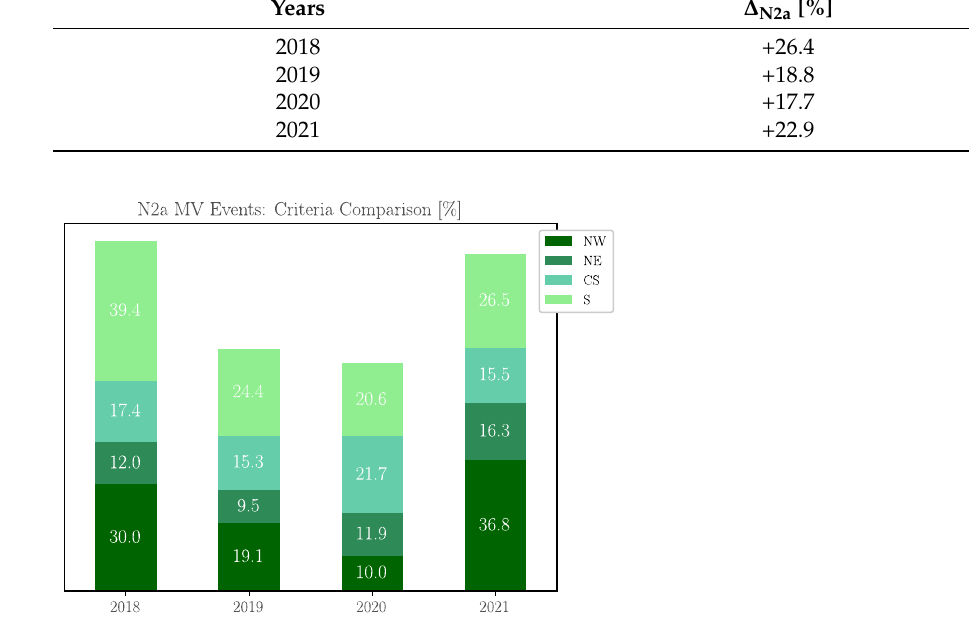
Figure 14. N2a percentual variation: a criteria comparison.